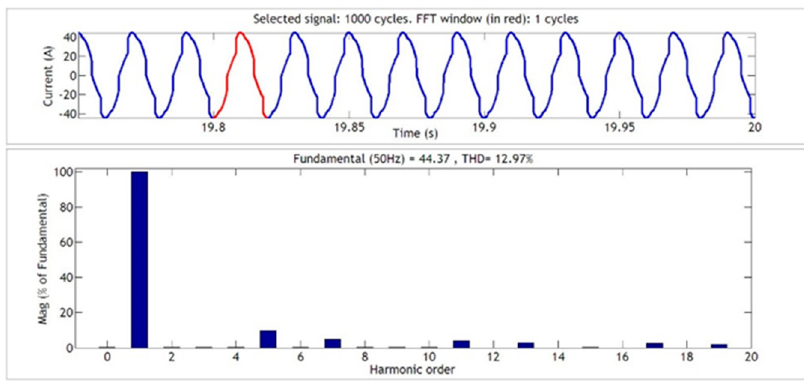
Figure 19. Before compensation unbalanced system source current FFT analysis.